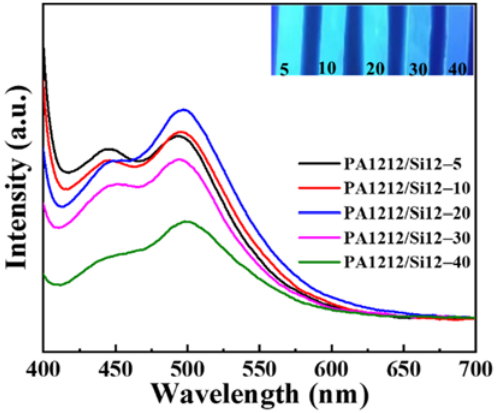
Figure 7. Fluorescence–emission curves of PA1212/Si12 copolymers.